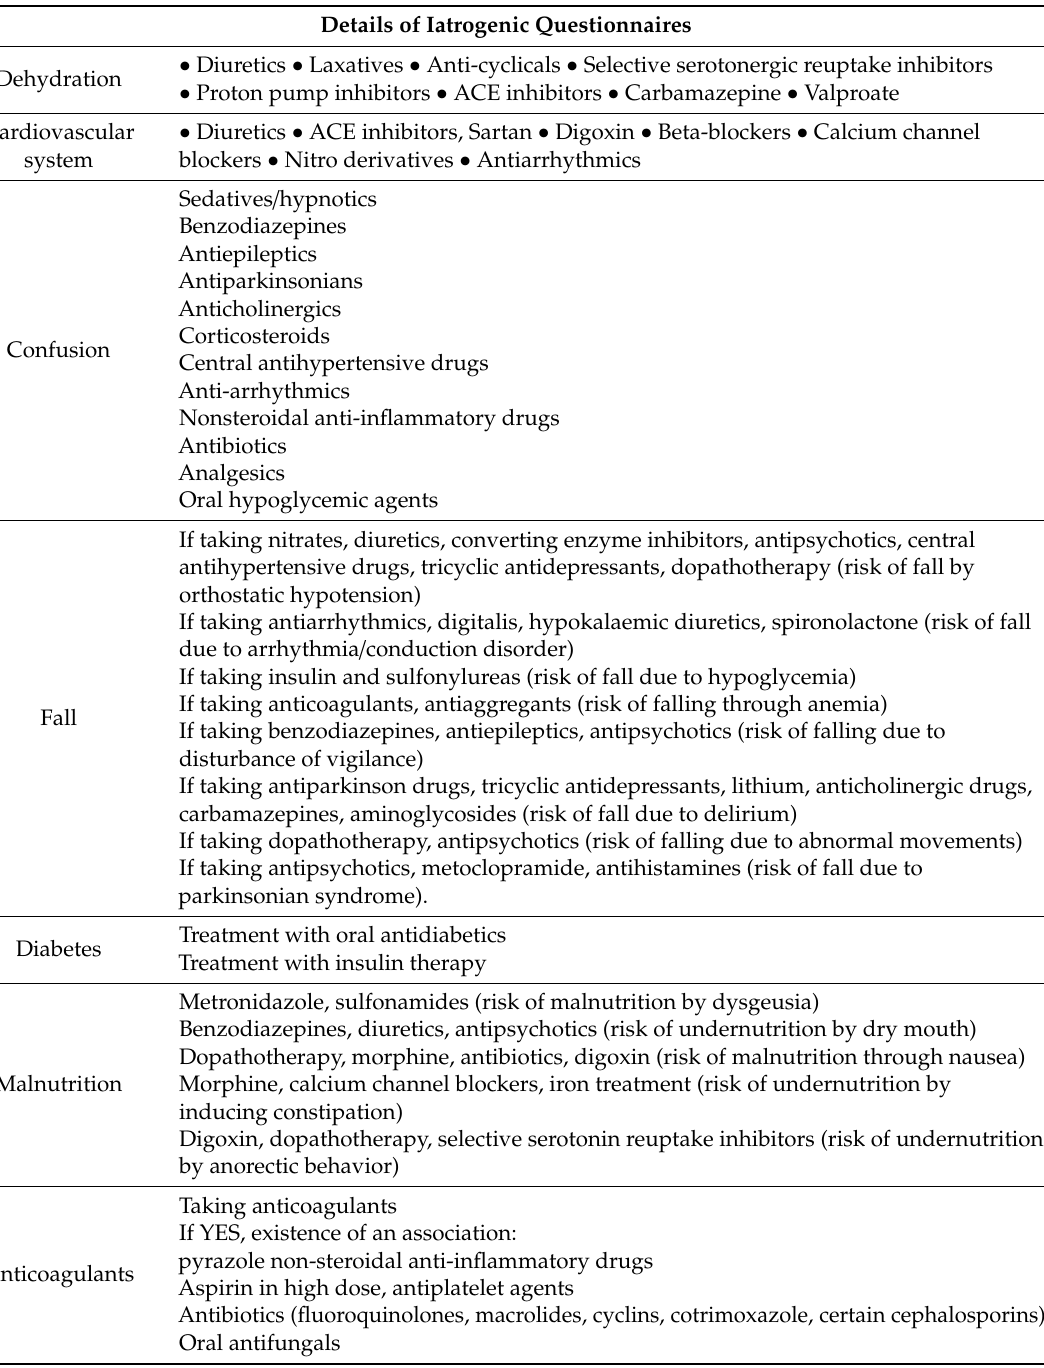
Table 3. Details of iatrogenic